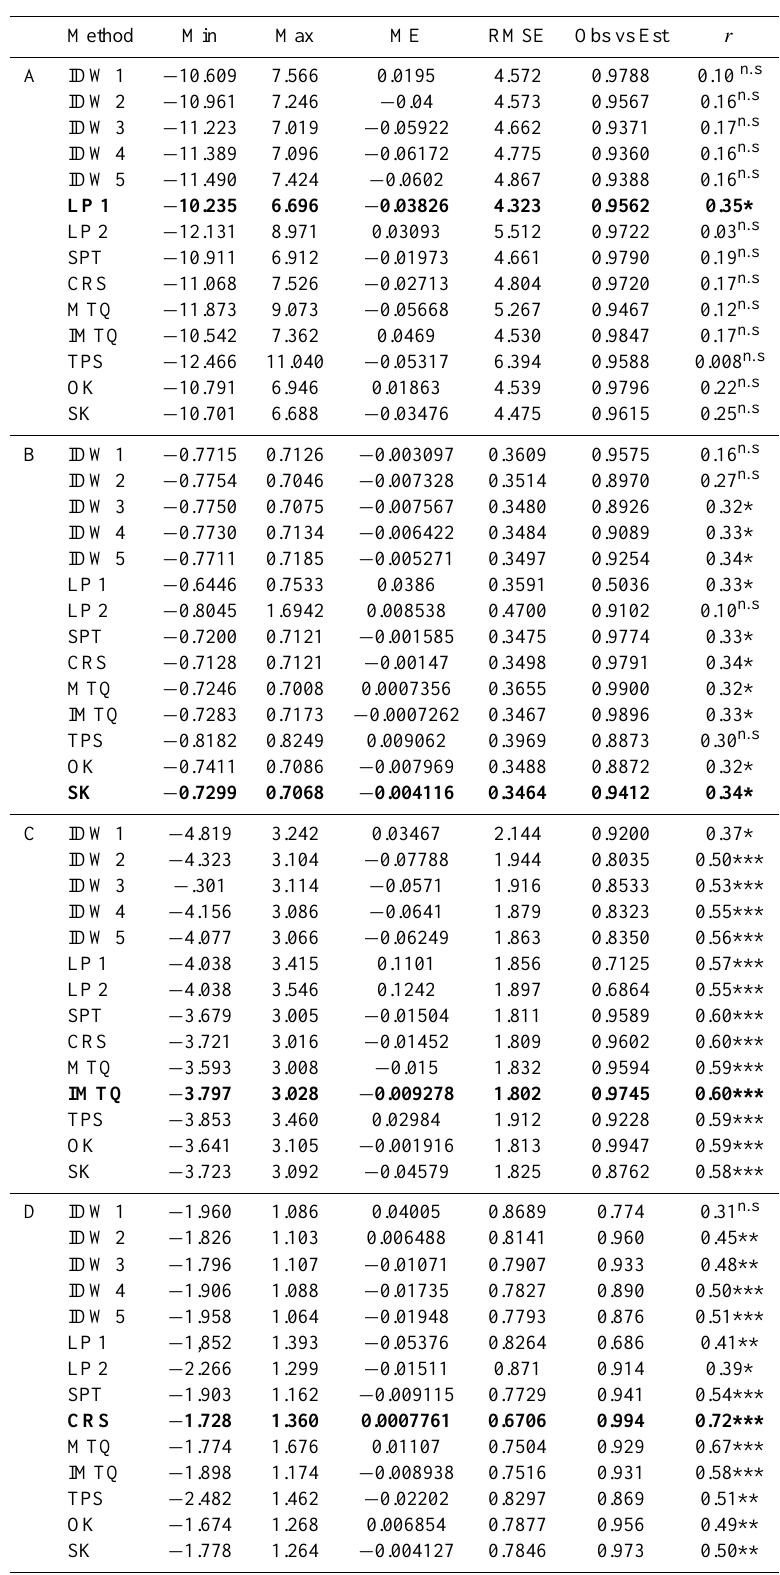
Table 4. Summary statistics of the accuracy of interpolation methods. Numbers in bold indicate the least biased method. (A) 4 days after the fire, (B) 16 days after the fire, (C) 34 days after the fire and (D) 45 days after the fire. Correlations between observed and estimated